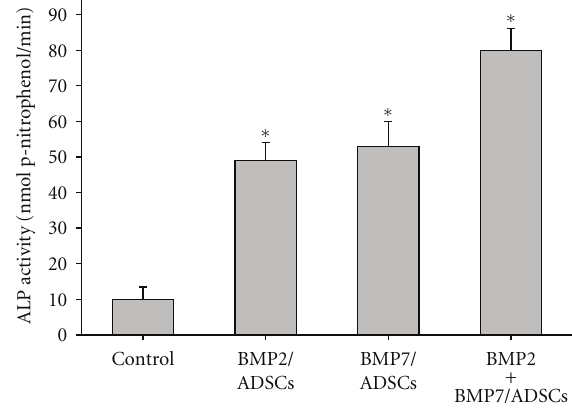
Figure 2: Detection of ALP activities for control, BMP2/ADSCs, BMP7/ADSCs, and BMP2 + BMP7/ADSCs groups at 14 day after cell seeding. Results are shown as mean ± SD ( n = 3 for each group, ∗ P < 0 .